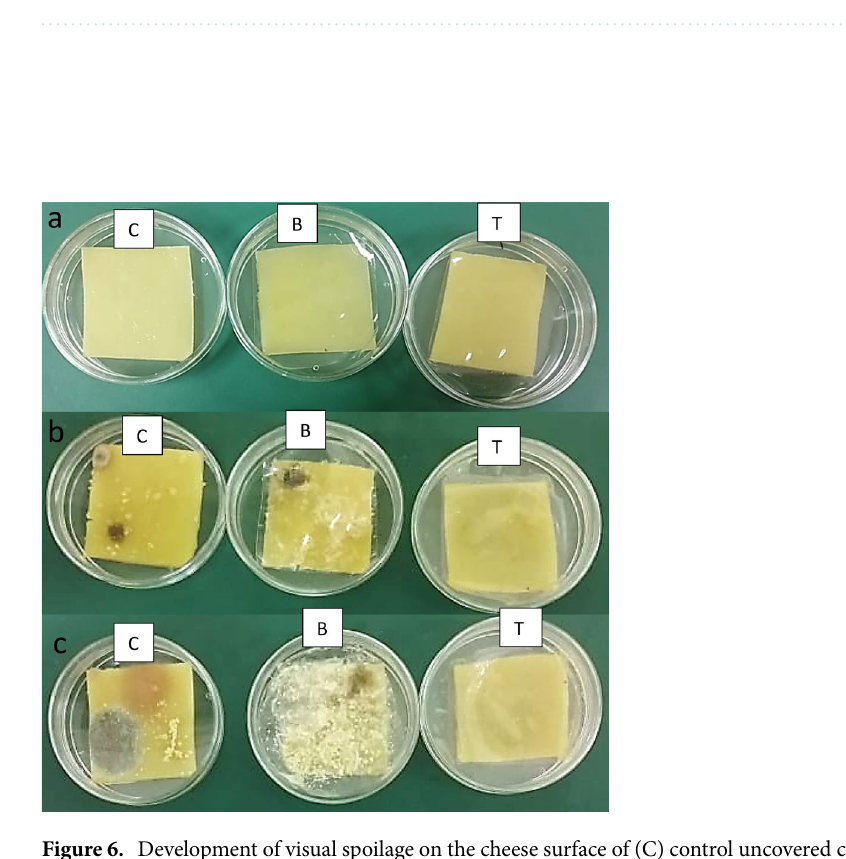
Table 3. Microbiological analysis of cheese. (C) Uncovered cheese, (B) covered with A film, (T) covered with A1 film. Results represent the mean (n) of 3 replicates ± sd. Means within the same microorganism group showing the same uppercase letters in the same row are not significantly different (p > 0.05) and means showing the same lowercase letters in the same column are not significantly different (p > 0.05). ND: not determined. N: not detected.